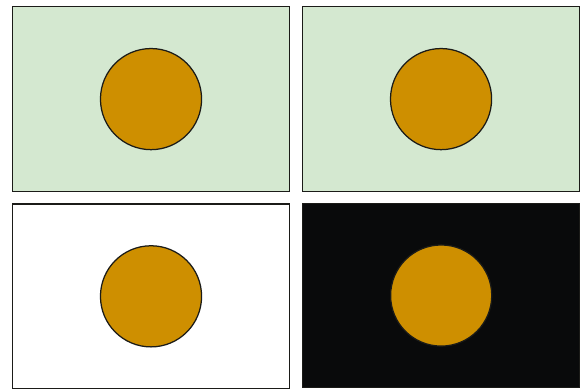
Figure 2: Simultaneous comparison phenomenon 1.